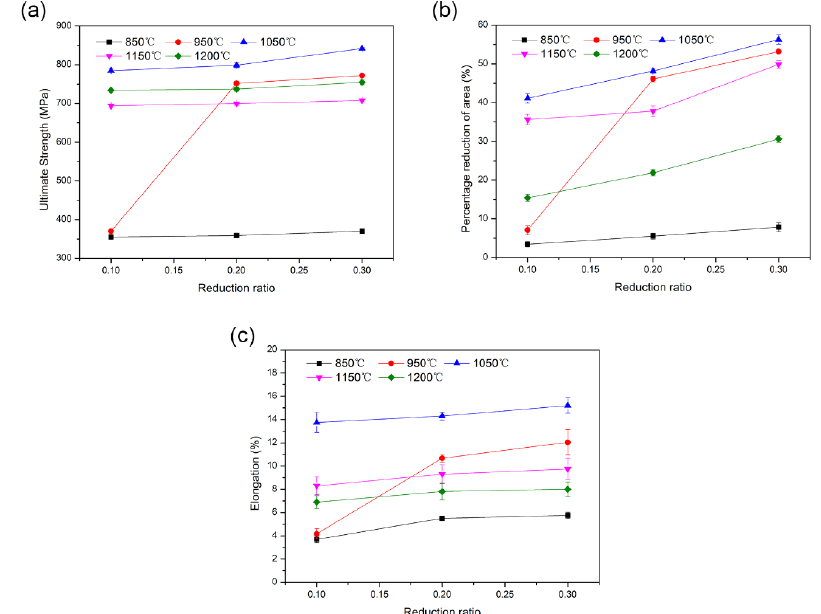
Figure 9. Room-temperature tensile properties recovery of crack healing zones at different healing conditions: ( a ) ultimate tensile strength, ( b ) percentage reduction of area, and ( c ) elongation.